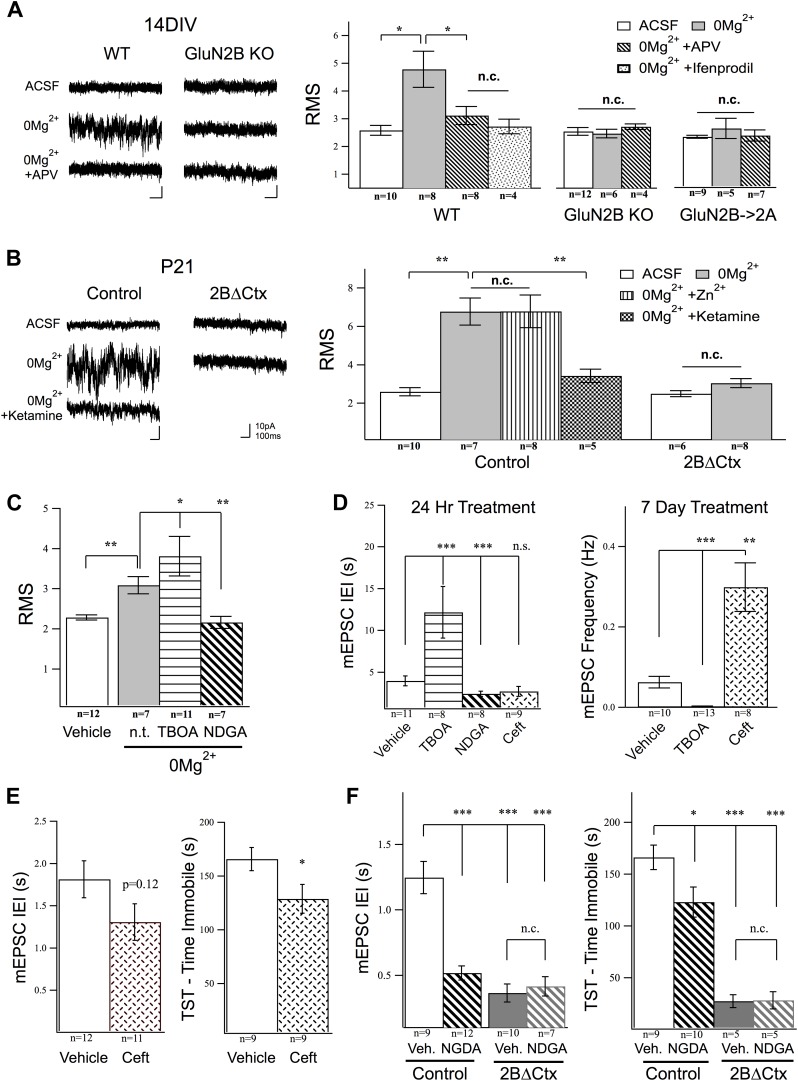
Activation of GluN2B-containing NMDARs by ambient glutamate regulates mEPSC frequency and depression-like behavior.Whole-cell recordings of cortical pyramidal neurons (Vhold −65 mV) under control conditions (ACSF) and in 0Mg2+ ACSF were used to test the subunit contribution of the NMDA receptor pool activated by ambient glutamate. (A) Perfusion of 0Mg2+ ACSF uncovered a tonic current in cultured cortical neurons (14 DIV) evidenced by an increase in baseline current noise that could be reversed by the NMDAR antagonist APV. This tonic NMDAR-mediated current was completely absent in GluN2B null neurons, including those in which GluN2B had been genetically replaced by GluN2A (GluN2B→2A). (B) Ambient glutamate also evoked a tonic current in acute brains slices that was suppressed by ketamine and was absent in 2BΔCtx slices (P21). (C–D) Manipulation of tonic activation of GluN2B-containing NMDARs alters mEPSC frequency in cortical cultures and pyramidal neurons in vivo, as well as expression of depression-like behavior. (C) Acute treatment of cultures with the glutamate transporter antagonist dl-TBOA enhanced the evoked current, while NDGA, which enhances glutamate transporter function, decreased this current. (D) Elevating ambient glutamate by blocking transporters with dl-TBOA, or decreasing it by enhancing glutamate transporter function with NDGA, or upregulating glutamate transporter expression using ceftriaxone bidirectionally regulated mEPSC frequency in cultured cortical neurons. (E) Enhancing glutamate transporter expression by i.p. injection of ceftriaxone resulted in a decrease in mEPSC IEI, and significant antidepressant-like action in control mice. (F) Injections of NDGA resulted in a significant decrease in mEPSC IEI in pyramidal neurons and decreased immobility in the TST. The effect of NDGA was mimicked and occluded on both measures in 2BΔCtx mice. Data points are mean ± sem. p-values are *<0.05, **<0.01, ***<0.001, and n values are shown for each experiment. n.c. = no significant change.